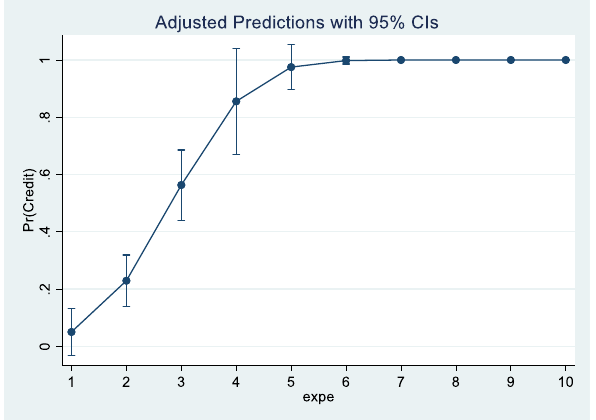
Figure 6. The non-linear impact of farming experience on the probability to adopt credit as a risk management strategy.